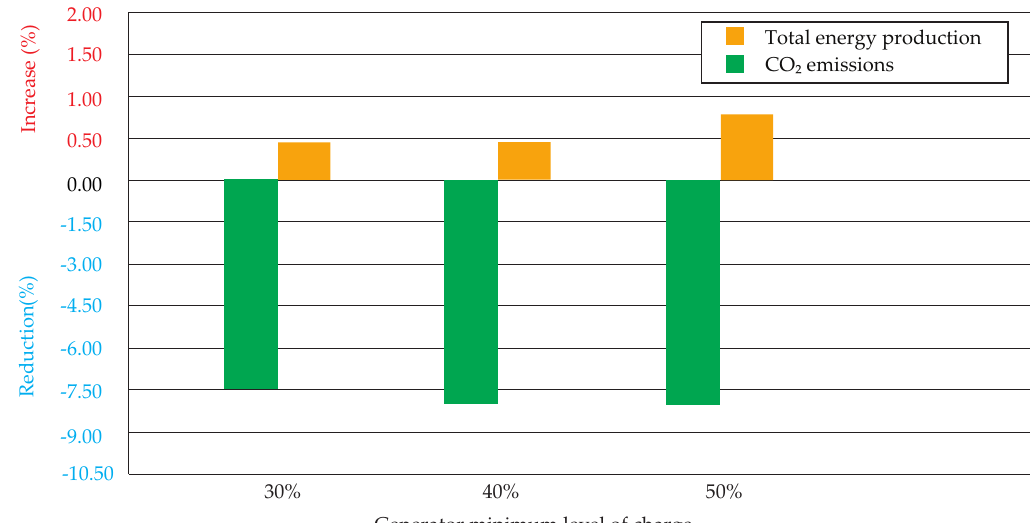
Figure 8. CO 2 emissions reduction and total energy generated increase for the case with four diesel generators and batteries in comparison to the case with four diesel generators without battery. The round trip efficiency is kept at 92% for the three minimum load levels simulated. The generators minimum load levels simulated are 30%, 40%, and 50%, the equivalent number of battery cycles during the operation are 43.8, 41.9, and 41.6, respectively.